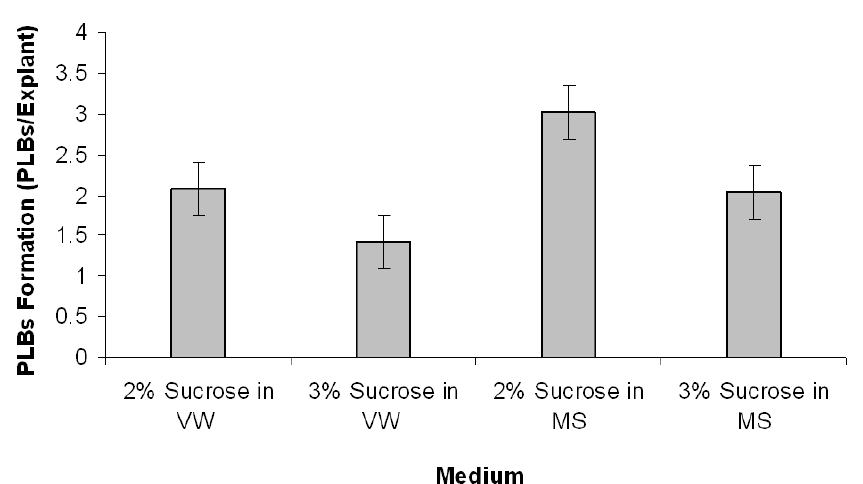
Fig. 1. Formation of PLBs after 4 weeks in media with different basal medium and concen- trations of sucrose. All media contained 15% (v/v) of coconut water. In each treatment 100 explants were studied. Bar = standard error